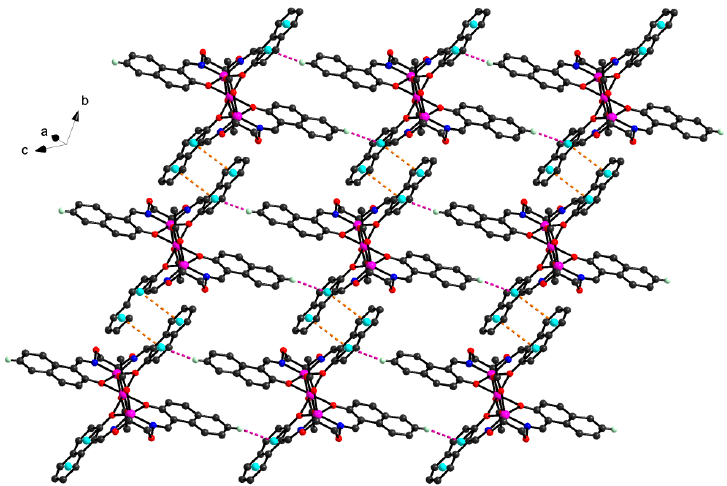
Figure 12. View of the 2D layered motif within 2 (hydrogen atoms, except those forming hydrogen bonds, are omitted for clarity).